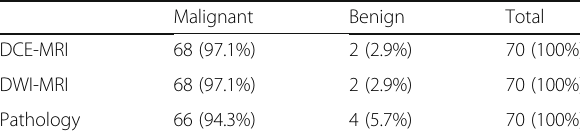
Table 1 The correlation between the number of cases diagnosed as benign or malignant by DCE-MR imaging, DWI, and pathological diagnosis